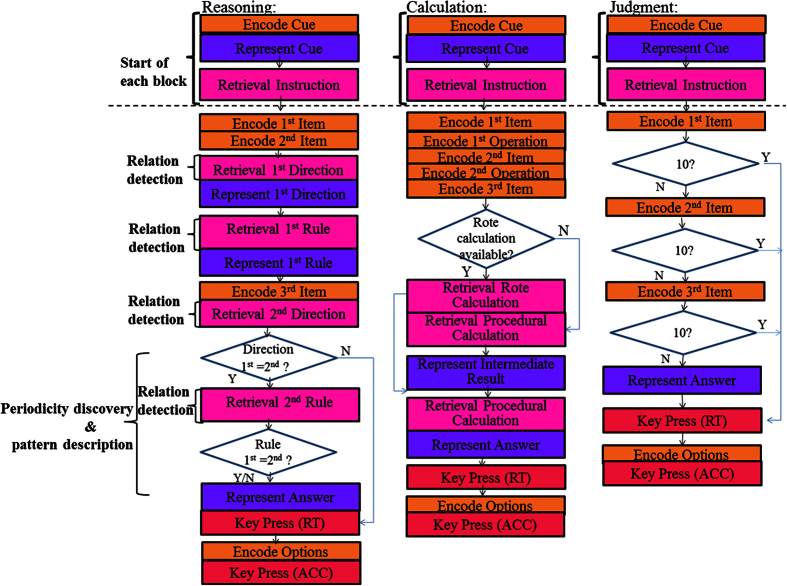
An overview of the model activity in three conditions.Boxes are not drawn to scale but indicate the general pattern of model activity. Orange corresponds to visual activity, blue to problem state, pink to declarative memory, and red-brown to motor activity.